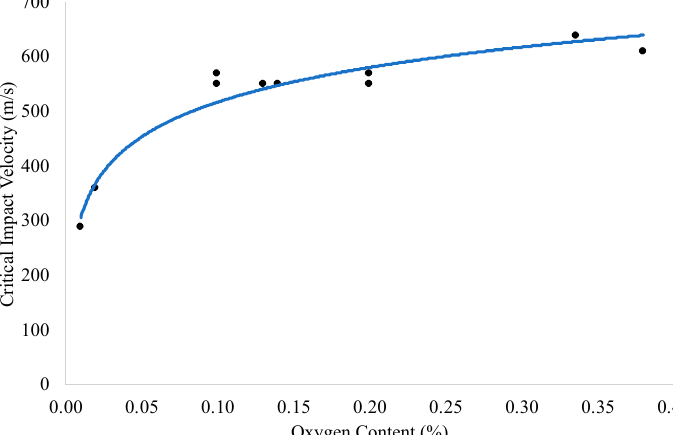
Figure 19. Unlike Al powder, which has been shown to yield a linear relationship between the critical impact velocity and oxygen content, we have graphically illustrated the logarithmic relation identified in this figure for gas-atomized commercially pure copper powder oxygen content and the critical impact velocity.